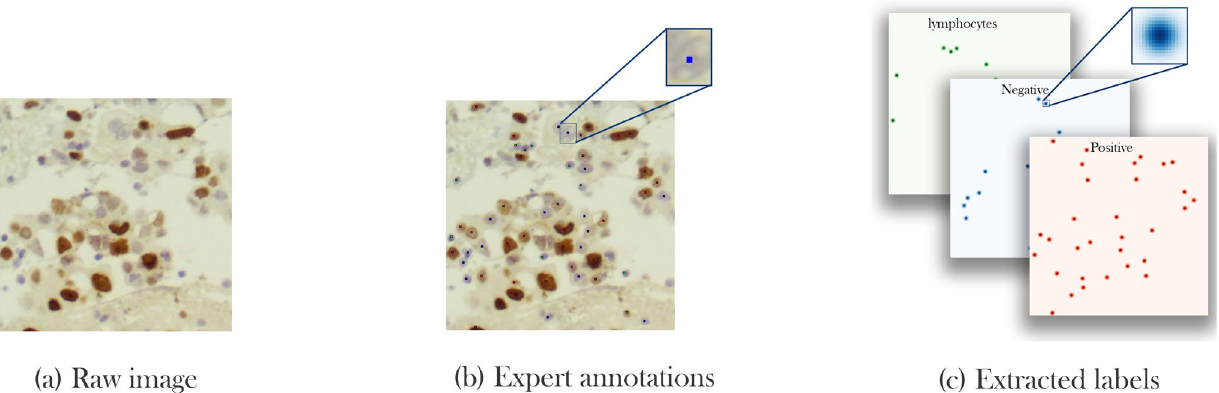
Figure 2. SHIDC-B-Ki-67 labeling process. ( a ) Capturing and cropping raw images, ( b ) specifying cell centers along with cell types by experts, ( c ) generating density maps from cell